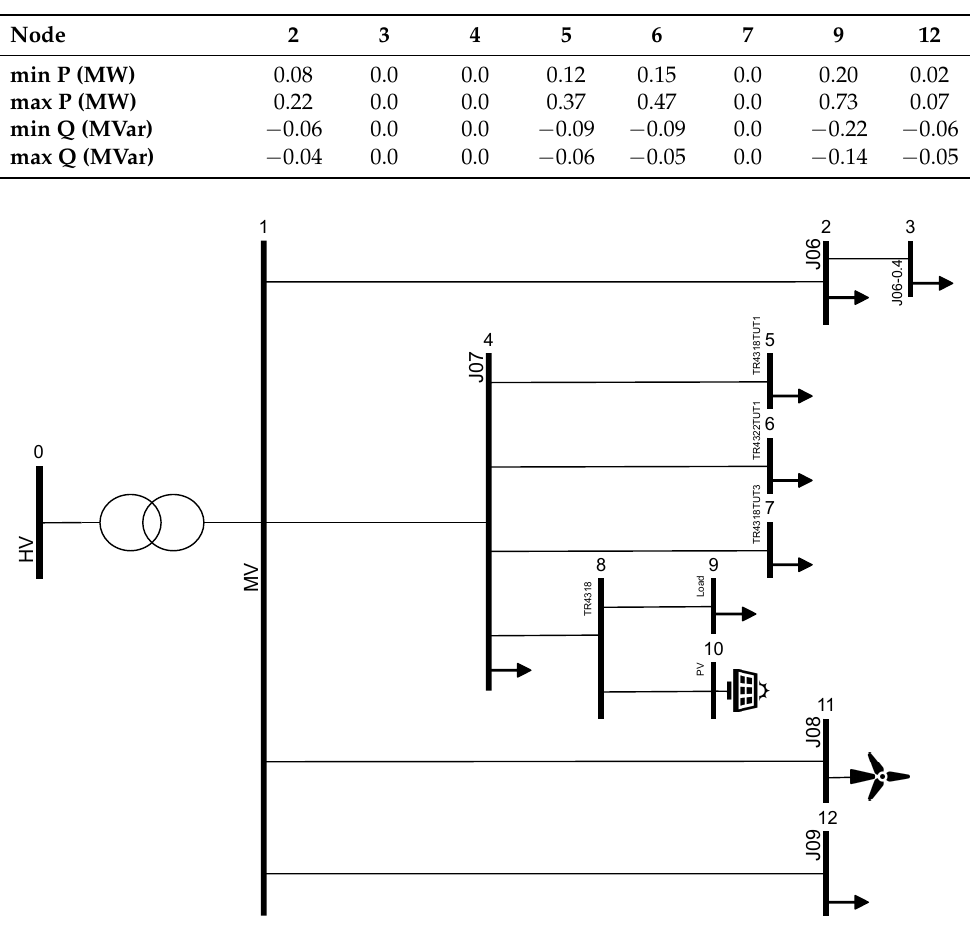
Figure 5. Sundom